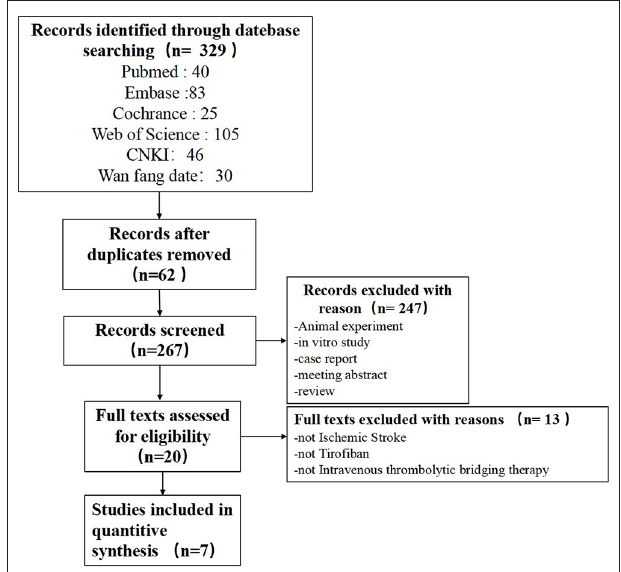
FIGURE 1 | Flow chart of the search and inclusion of